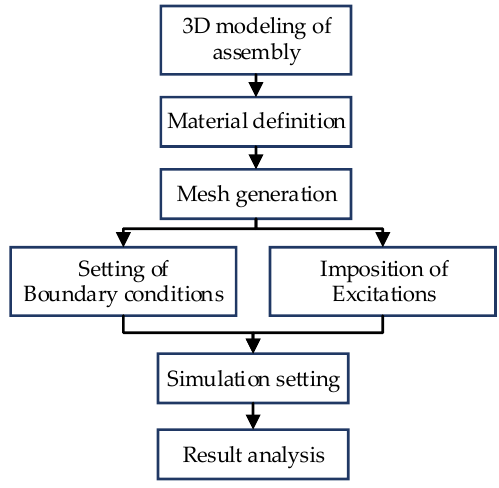
Figure 3. Flow chart of simulations.